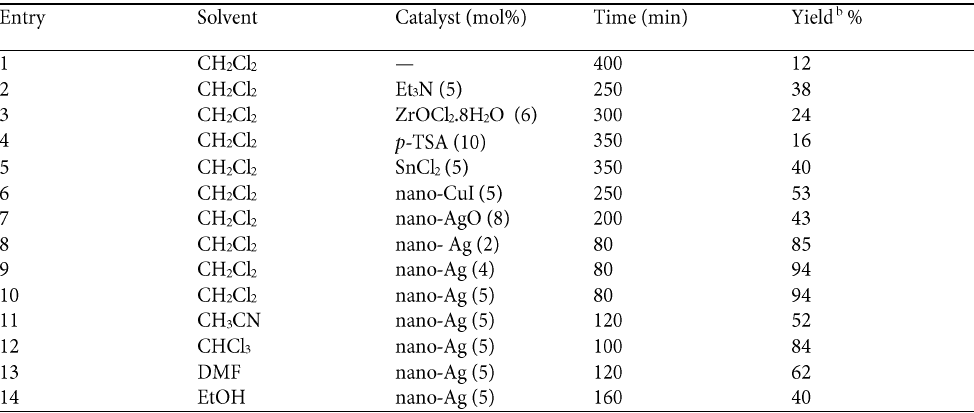
Fig. 4. EDS of nanocatalyst Fig. 5. The elemental mapping of nanostructure in the extract Table 1: Optimization of reaction conditions